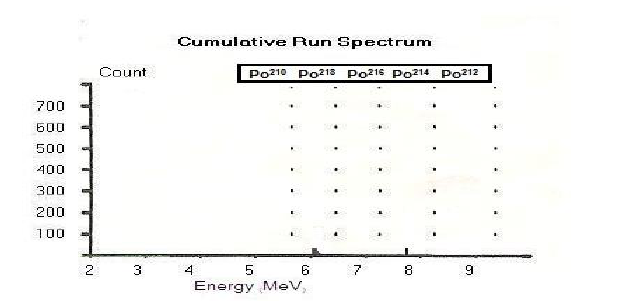
Fig. 5: Spectrum of location